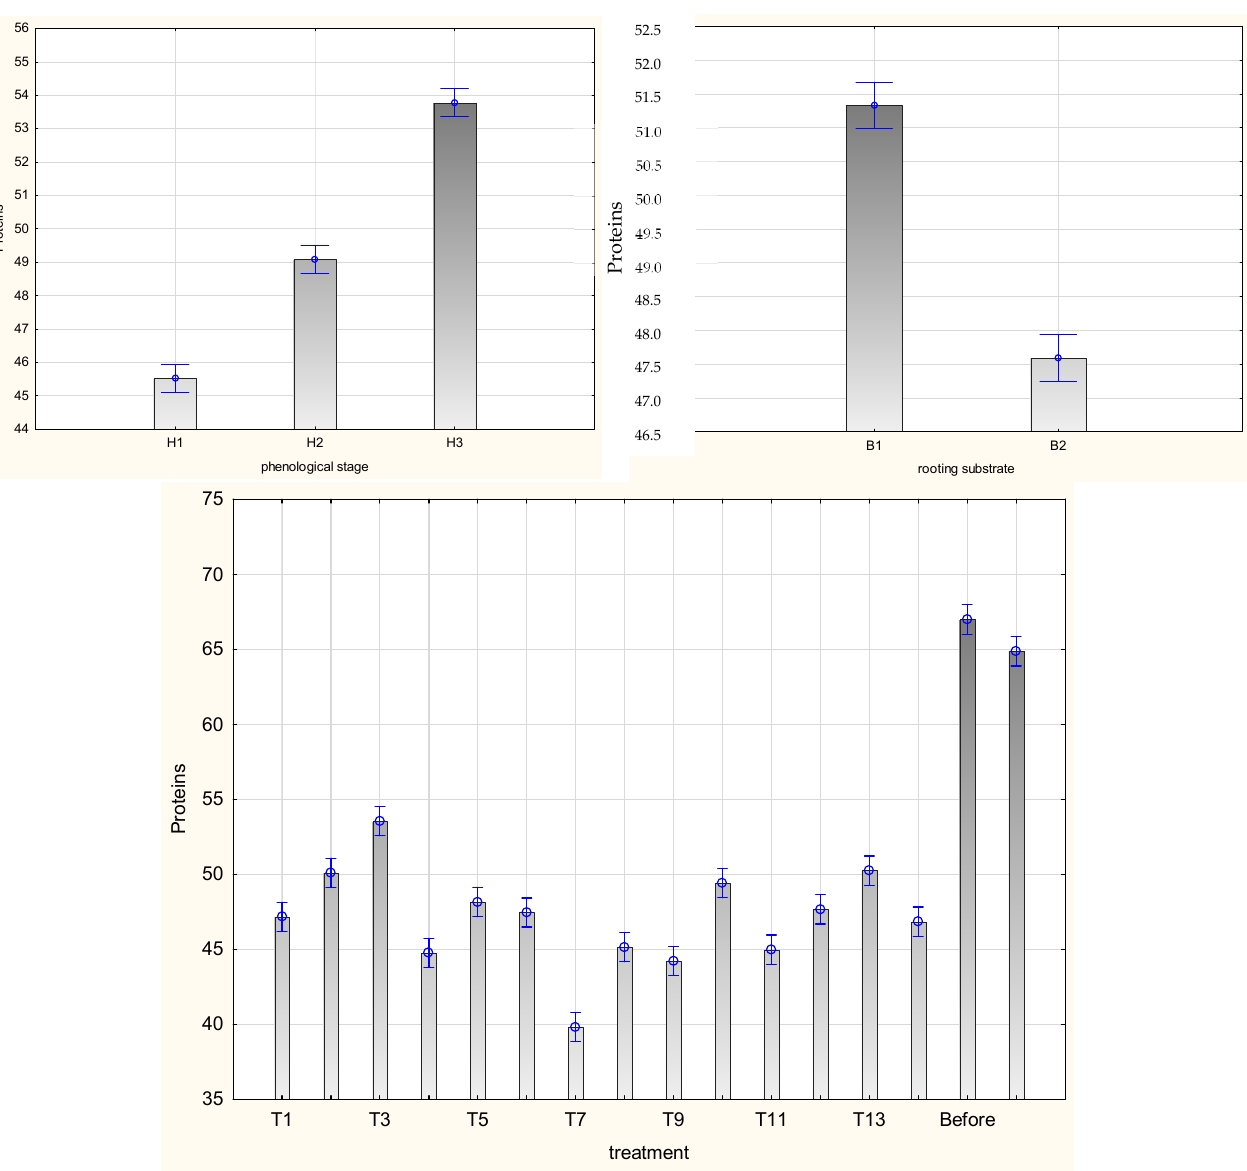
Figure 11. Content of soluble proteins ( µ g · mg − 1 FW) in leaves of Rosa ‘Hurdal’ cuttings prepared from three phenological stages (H1–H3) of shoots and rooted in two rooting substrates after treatment by rooting enhancers. B1—peat–perlite; B2—peat–sand; H1—flower buds closed (BBCH 54 504; flower buds still closed); H2—flowers opened (69 605; full flowering, at least 50% of flowers open); H3—immediately after petal shedding (69 629; end of flowering of second order stem: all petals fallen); and treated: T1—the control cuttings; T2—0.4% IBA (Ukorzeniacz A aqua ); T3—0.2% NAA (Ukorzeniacz B aqua ); T4, T5, T6, T7, T8, T9—Algae Extract: watering with 0.4% or 0.6% Bio Rhizotonic (10 mL) 1, 2, or 3 times (after planting and 10 and 20 days later); T10, T11, T12—Organic Preparation—watering with 0.1%, 0.2%, or 0.4% Root Juice™ (10 mL) after planting; T13, T14—Plant Extract—watering with 0.012% or 0.02% Bio Roots (10 mL) after planting. The degree of rooting on a 5-point scale: 1—only a callus, without formed roots; 2—at least one short root; 3—a few longer roots; 4—roots visibly developed, differentiated by the length; 5—strong roots starting to form a root ball, well developed. Vertical bars denote 95% confidence intervals for the mean of counts (one- way ANOVA).